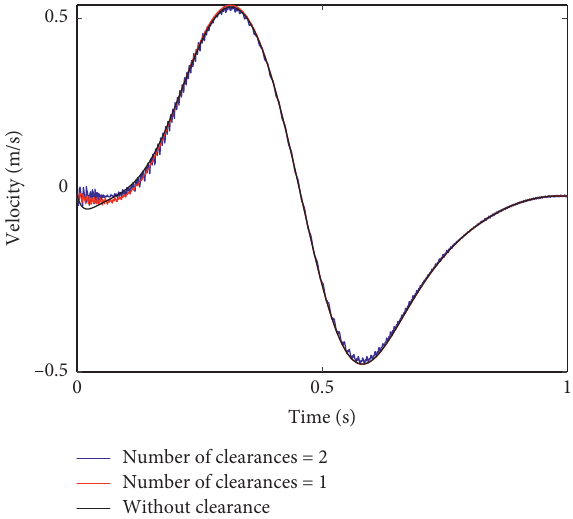
Figure 12: Collision force with different numbers of